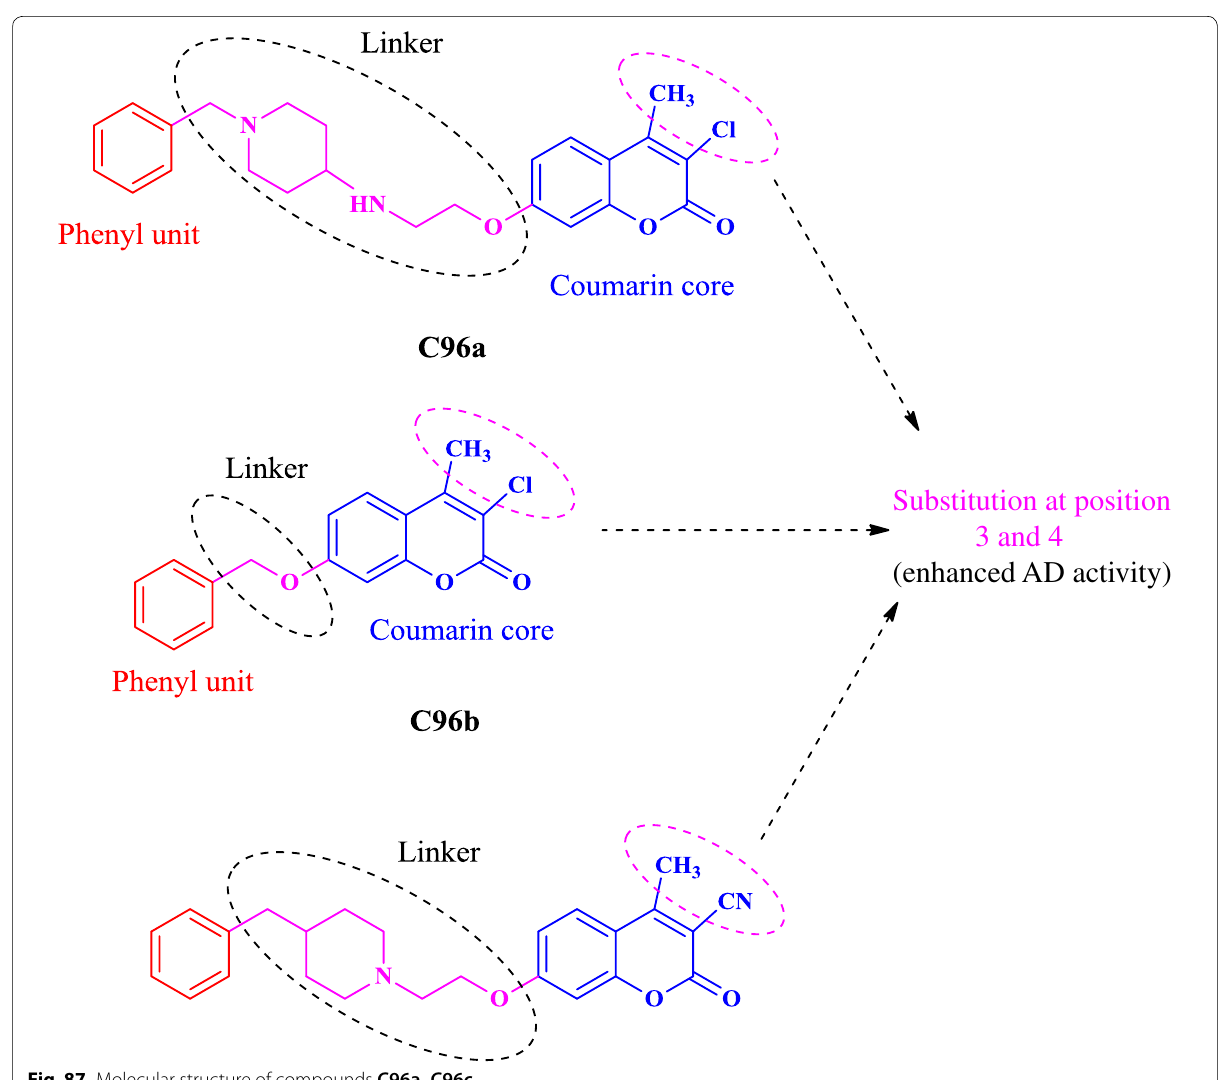
Fig. 87 Molecular structure of compounds C96a –